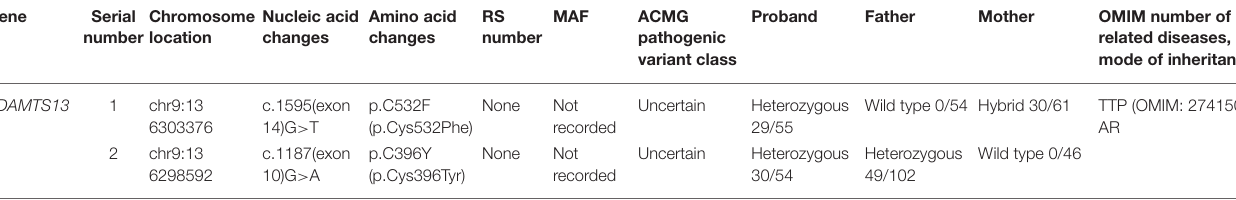
TABLE 2 | Data on genetic variants. Gene